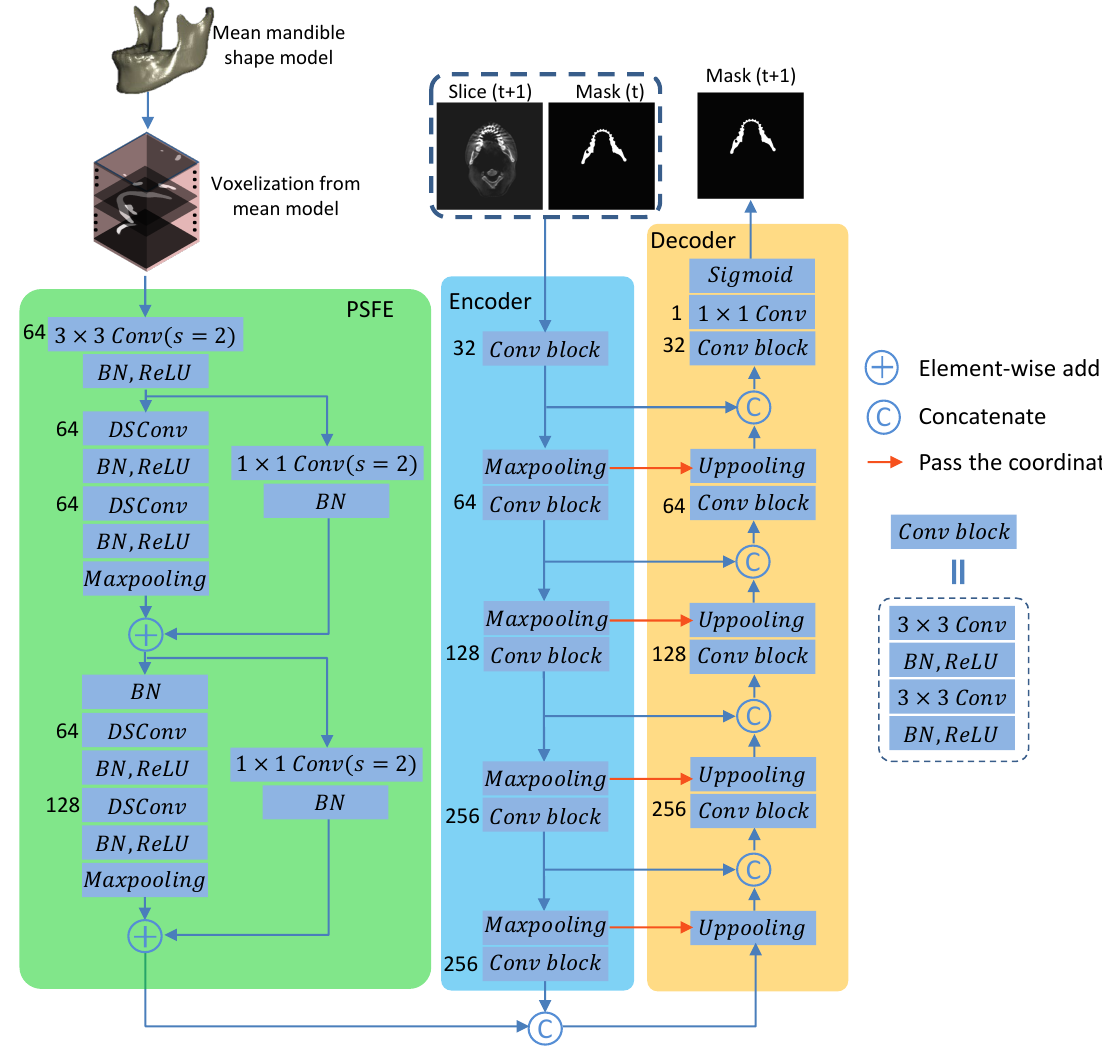
Figure 5. Details of each unit of SASeg. Each unit of SASeg consists of the PSFE, an encoder and a decoder. The number of channels is indicated in the left of each convolution. The PSFE module is inserted at the last layer of the encoder to capture the mandible prior